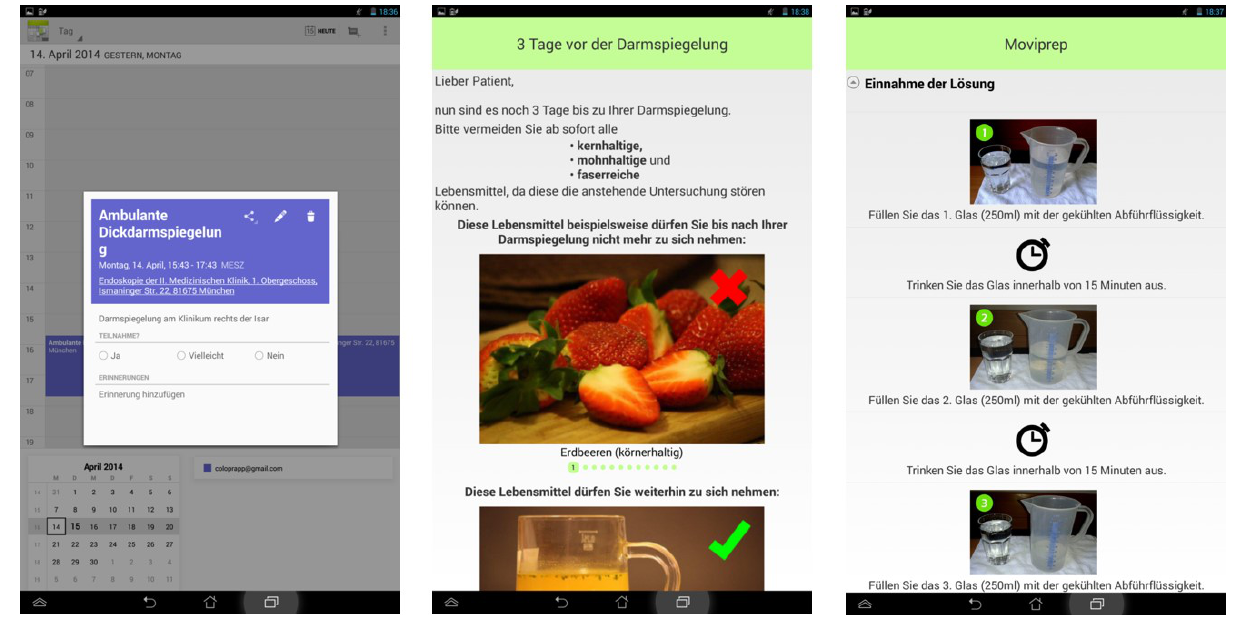
Figure 2. Screenshot examples of app function, calendar function (left), dietary recommendations (middle), and purgative instructions